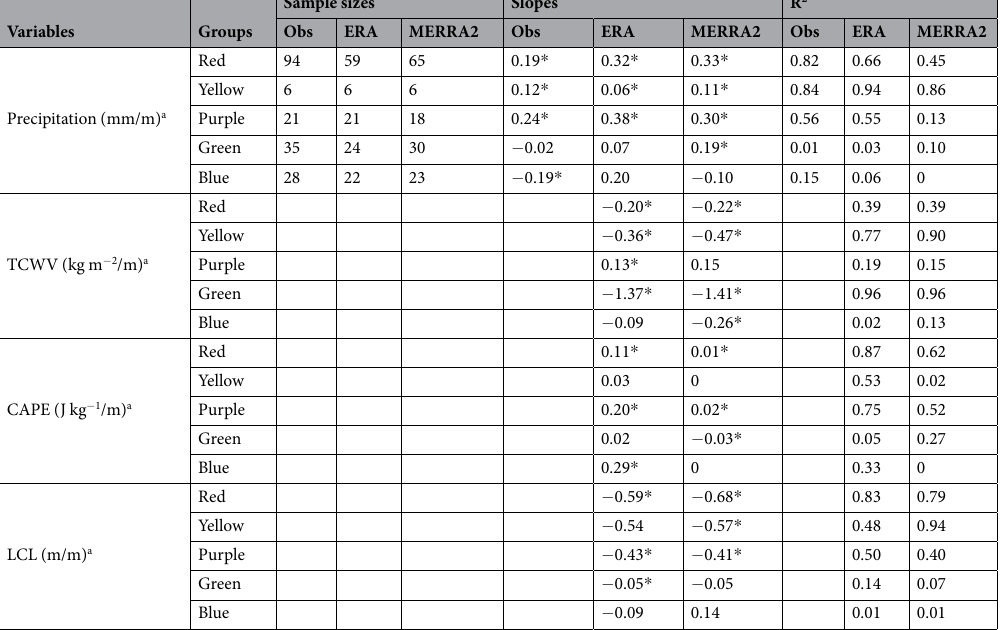
statistically significant although Group Green displays the smallest rate of − 0.05 m m − 1 (Table 1). It appears that 4000 m is a pivotal height for sharp changes in moisture and LCL based on the ERA-Int reanalysis. MERRA2 presents a largely consistent pattern with ERA-Int in terms of TCWV vertical gradient signs and magnitudes for all groups except for Group Blue for which MERRA2 shows a much larger negative TCWV gradient than ERA-Int (Table 1, Figs 5c and 4c). Consistency is also striking for LCL between MERRA2 and ERA-Int (Table 1, Figs 5e and 4e), except for Group Blue. For CAPE, MERRA2 presents statistically signifi- cant positive gradients for Groups Red and Purple as in ERA-Int although the magnitudes are much smaller for MERRA2 (Table 1). For Group Green, MERRA2 exhibits a statistically significant negative gradient of CAPE while ERA-Int shows a positive gradient. Also, MERRA2 displays zero gradients for Groups Yellow and Blue while ERA-Int shows positive gradients (Table 1). As will be explained in the Data and Method section, it appears that MERRA2’s CAPE computed using the 6-hourly model data is under-estimated when compared to ERA-Int’s CAPE computed using the hourly model data. However, the CAPE patterns for MERRA2 appear to be reasonable judging from the strong consistency between MERRA2 and ERA-Int in the gradients of precipitation, TCWV, LCL, and CAPE for Groups Red, Purple and to a lesser extent Yellow. The above analyses based on ERA-Int and MERRA2 suggest that the observed positive gradients of precip- itation for Groups Red and Yellow is due to the combined effects of negative LCL gradients and positive CAPE gradients that overwhelm those of negative TCWV gradients. For Group Purple, positive TCWV and CAPE gradients combined with a negative LCL gradient result in a large positive gradient of precipitation. For Group Green, ERA-Int suggests that the combined effects of a small negative LCL gradient and a small positive CAPE gradient may just balance out those of a negative TCWV gradient which gives rise to little change of precipitation with elevation for this group. For Group Blue, MERRA2 indicates that the observed negative gradient of precipi- tation is due to the combined effects of increasing LCL and decreasing TCWV with elevation. Horizontally, both ERA-Int and MERRA2 reveal that during the wet season large precipitation over the south- eastern TPS (Group Green) is due to the combined effects of abundant moisture, high CAPE and low LCL while the opposite is true for the Qaidam Basin (Group Yellow). This clear contrast is related to the prevailing atmos- pheric circulations in the different areas in the wet season. Group Green is located in the southeastern TPS that is affected primarily by the South and East Asia monsoons and not only TCWV but also CAPE and LCL favor precipitation. On the other hand, Group Yellow is located in a comparably low basin in the northwestern TPS surrounded on all sides by mountain ranges and is affected mainly by the moisture depleted westerlies and less so by the monsoons, which result in low CAPE and TCWV but high LCL, all detrimental to the development of pre- cipitation there. For Groups Red and Purple in the same elevation range, more moisture, higher CAPE and lower LCL lead to more precipitation for the former than for the latter. In the interior of the TPS (Group Blue), moisture is low but CAPE is relatively high and LCL is relatively low, giving rise to moderate precipitation. Thus, largely consistent with the southeast-northwest horizontal gradient of precipitation shown in Fig. 2b, both TCWV and CAPE decrease but LCL increases from the southeast to the northwest of the TPS (Figs 4 and 5, Supplementary S6 and S7).